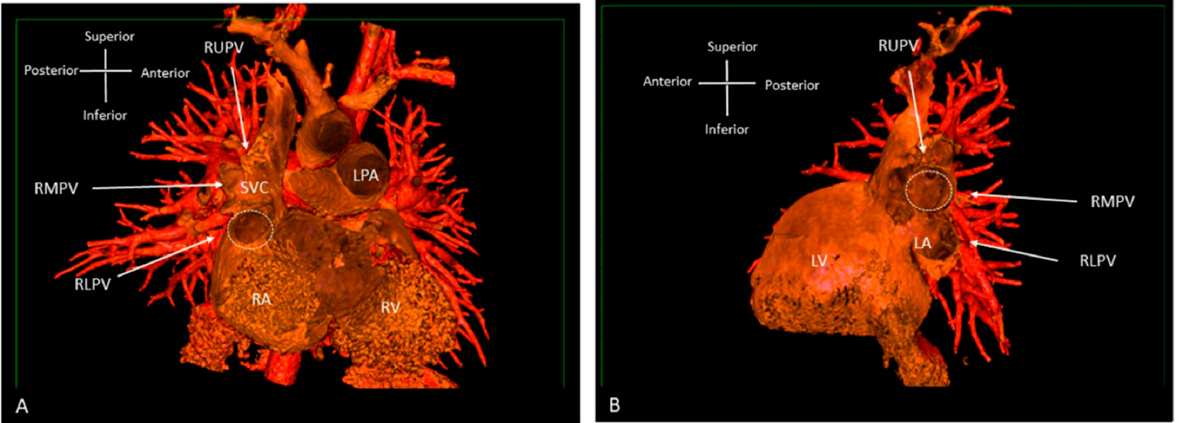
Figure 8. Three-dimensional rendered images from CT, demonstrating the appearance of Superior Sinus Venosus ASD. ( A ) Demonstrates a superior sinus venosus ASD as outlined by the dashed line—seen from the right atrial aspect. RUPV and RMPV drain anomalously to the SVC. RLPV can be seen draining to LA. ( B ) Depicts a superior sinus venosus ASD from the left atrial aspect, allows imaging of the anomalous drainage of the RUPV and RMPV to the SVC. RLPV illustrated draining into the LA. LA: Left atrium; LPA: Left pulmonary artery; LV: Left ventricle; RA: Right atrium; RV: Right ventricle; SVC: Superior vena cava; RLPV: Right lower pulmonary vein; RMPV: Right middle pulmonary vein; RUPV: Right upper pulmonary vein.